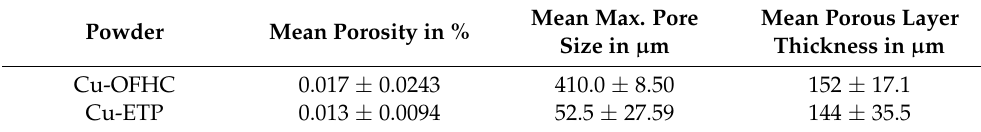
Table 4. Porosity analysis of three density cubes per powder via image analysis.